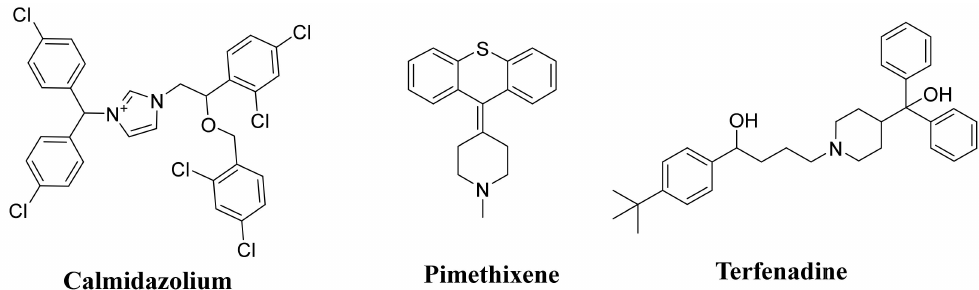
Figure 12. LuxR-regulated QS antagonists—calmidazolium, pimethixene, and terfenadine. This work was then extended to the synthesis and biological evaluation of simplified built on the imidazolium backbone found in calmidazolium, namely disubstituted imi- dazolium salts with benzhydryl, fluorenyl, or cyclopentyl substituent, and alkyl chains of various lengths. This investigation led to a fluorenyl and dodecyl disubstituted imida- zolium 119 with an IC 50 of 1.4 µ M (Scheme 16) [64].